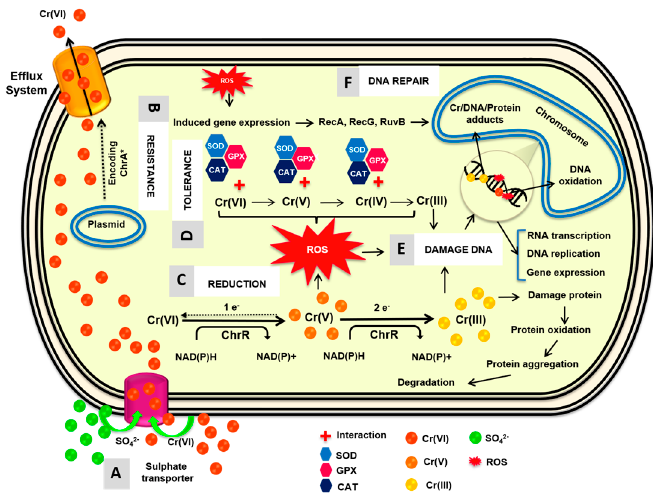
Figure 7. Possible mechanisms of interaction of Stenotrophomonas maltophilia and chromate. A . Chromate enters the bacterial cell through sulfate transporter. B . Resistance: Plasmid DNA encoded efflux systems. * This system in some bacteria is ChrA transporter. C . Intracellular reduction of Cr(VI) to Cr(III) involves soluble chromate reductase ChrR which requires NAD(P)H as an electron donor. D . Tolerance: To